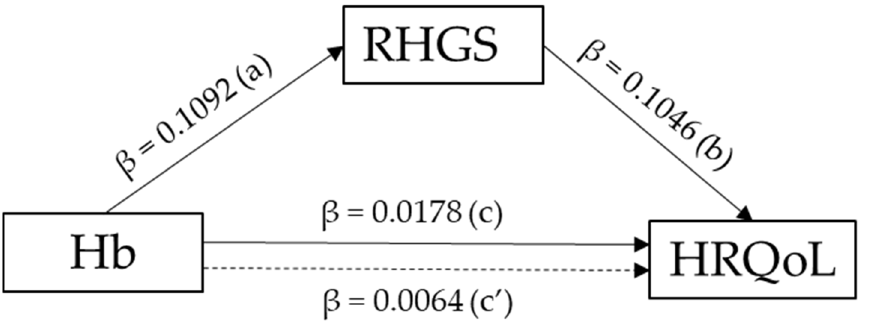
Figure 3. Mediation analysis. Path coefficients of hemoglobin (Hb) on health-related quality of life (HRQOL) through relative handgrip strength (RHGS). a: estimated coefficient for the regression with anemia predicting RHGS; b: estimated coefficient for the regression with RHGS predicting HRQoL; c = total effect of anemia on HRQoL; c ´ = direct effect of anemia on HRQoL; ab = indirect effect of anemia on HRQoL through RHGS.